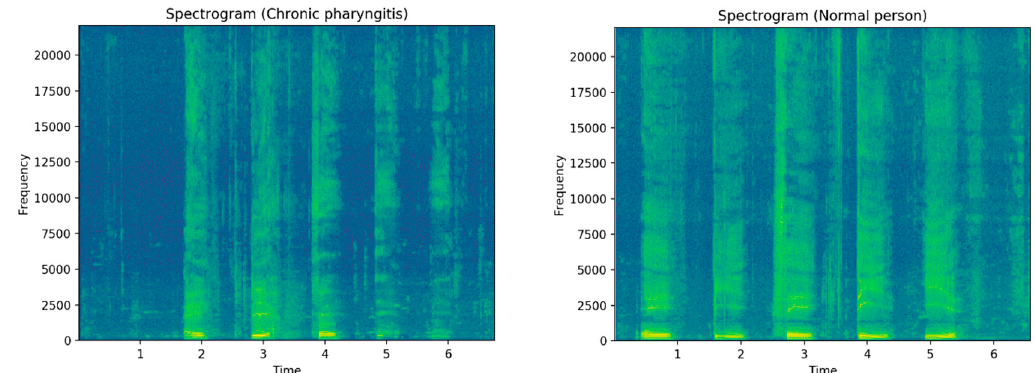
Figure 4. Comparison of the spectrum of patients with chronic pharyngitis and normal people.